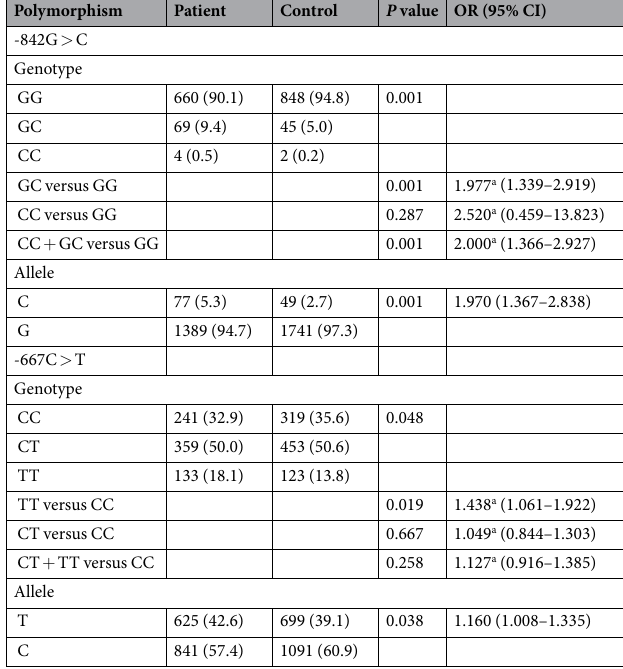
Table 2. Genotype and allele distribution of -842G > C and -667C > T in patients and controls. a Data were calculated by unconditional logistic regression with adjustment for age and